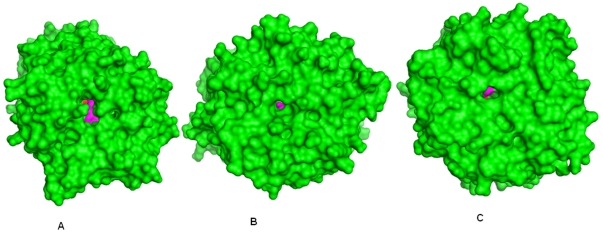
20th ns bound form structure of porcine, human and A. thaliana POPs.β-propeller pore size was found to be biggest in porcine, while in human and A. thaliana it was small. Drug (ZPR) is shown in magenta color, active site is colored red.